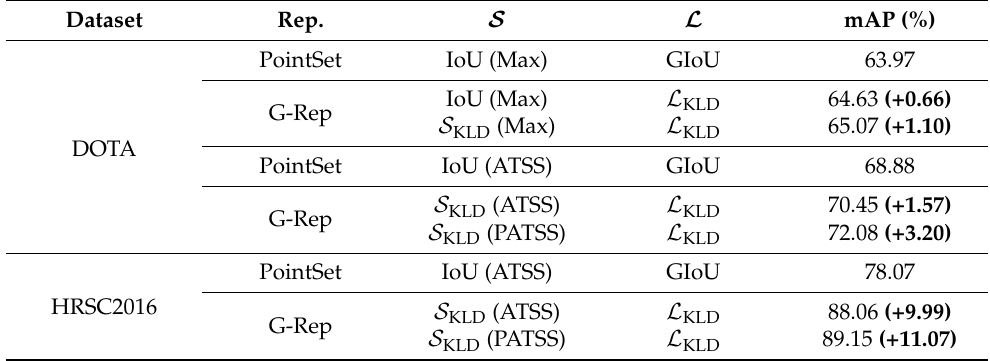
Table 2. Ablation study of G-Rep for PointSet on DOTA and HRSC2016. S and L represent the label assignment strategy and regression loss function,